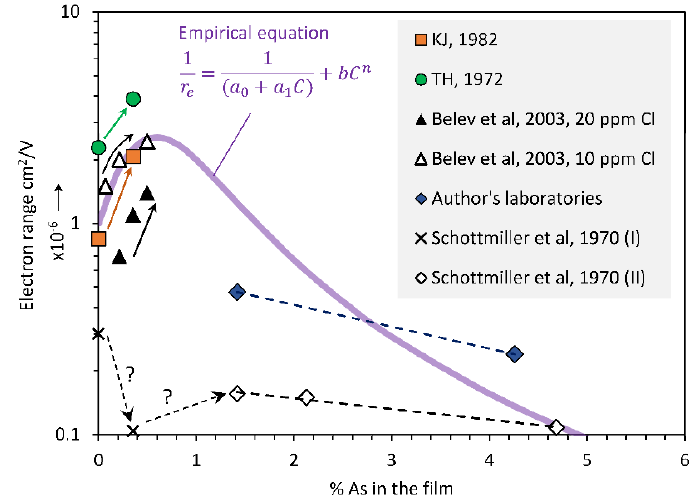
Figure 5. A semilogarithmic plot of the dependence of the electron range r e on the As content C in the film. The initial electron lifetime has batch ‐ to ‐ batch variations. Data were extracted, reanalyzed, converted to the average As content in the film, and then replotted. KJ, 1982, and TH, 1972, are [9,10], respectively, Schottmiller et al., 1970, is [8], Belev, 2003, is [16]. Note: a 0 = 1.0 × 10 − 6 cm 2 V − 1 , a 1 = 4.0 × 10 − 6 cm 2 V − 1 percent − 1 , b = 0.3 × 10 6 V cm − 2 percent − 2.2 , and n = 2.2.